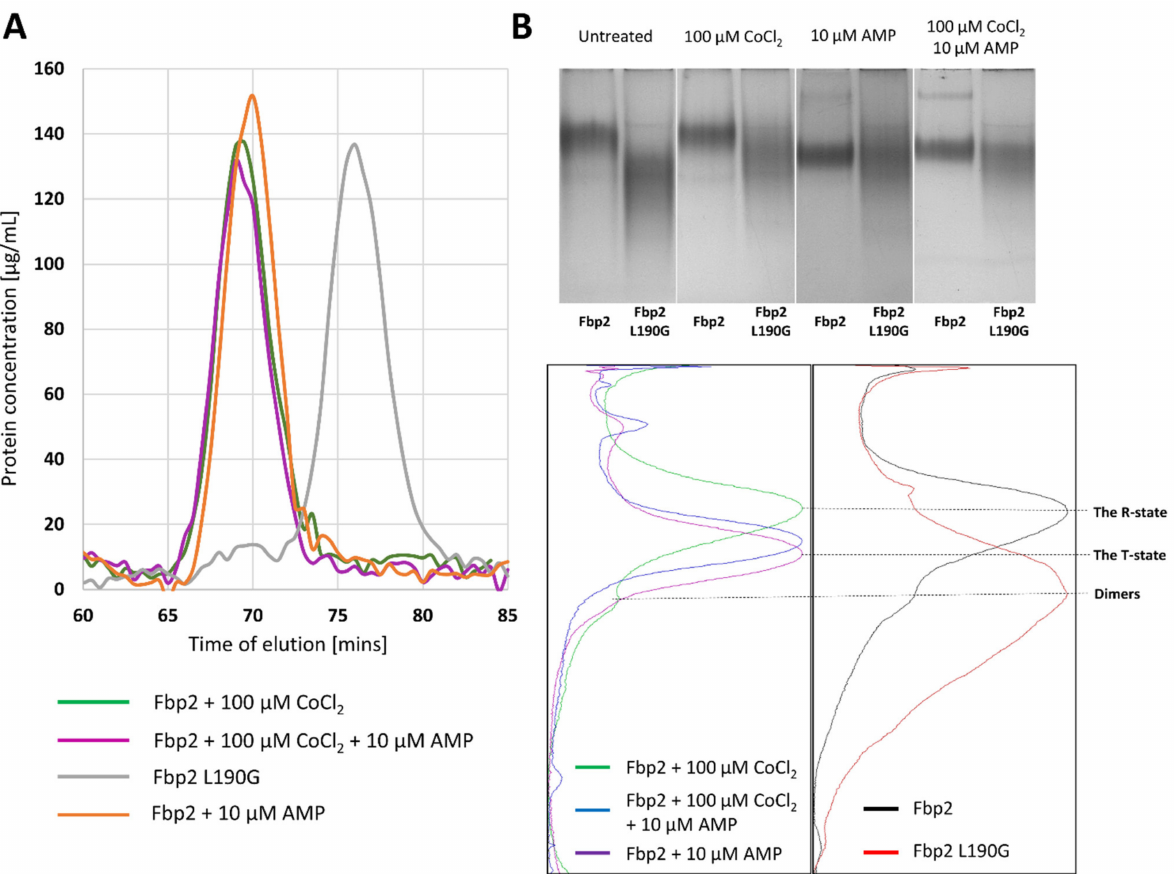
Figure 2. Co 2+ does not modulate oligomerization of Fbp2 but it affects the AMP-bound protein migration in the Native- PAGE. ( A ) Size-exclusion chromatography (SEC) reveals that in a presence of AMP and Co 2+ , Fbp2 adopts tetrameric conformation. As a control, we used the Fbp2 L190G mutein which cannot tetramerize and adopts dimeric form only. ( B ) Migration of the Co 2+ -saturated and Co 2+ -free Fbp2 in the Native-PAGE is similar. In the absence of ligands, Fbp2 migrates mainly as the R-state tetramers, although the small amount of dimers is also visible (black line). The dimeric arrangement is the only confirmation for the Fbp2 L190G mutein (red line). The mobility of the AMP-induced T-state Fbp2 (magenta line) is increased as compared to the R-state. However, in the simultaneous presence of Co 2+ and AMP, the mobility of Fbp2 (blue line) does not fully reflect that observed in the presence of AMP